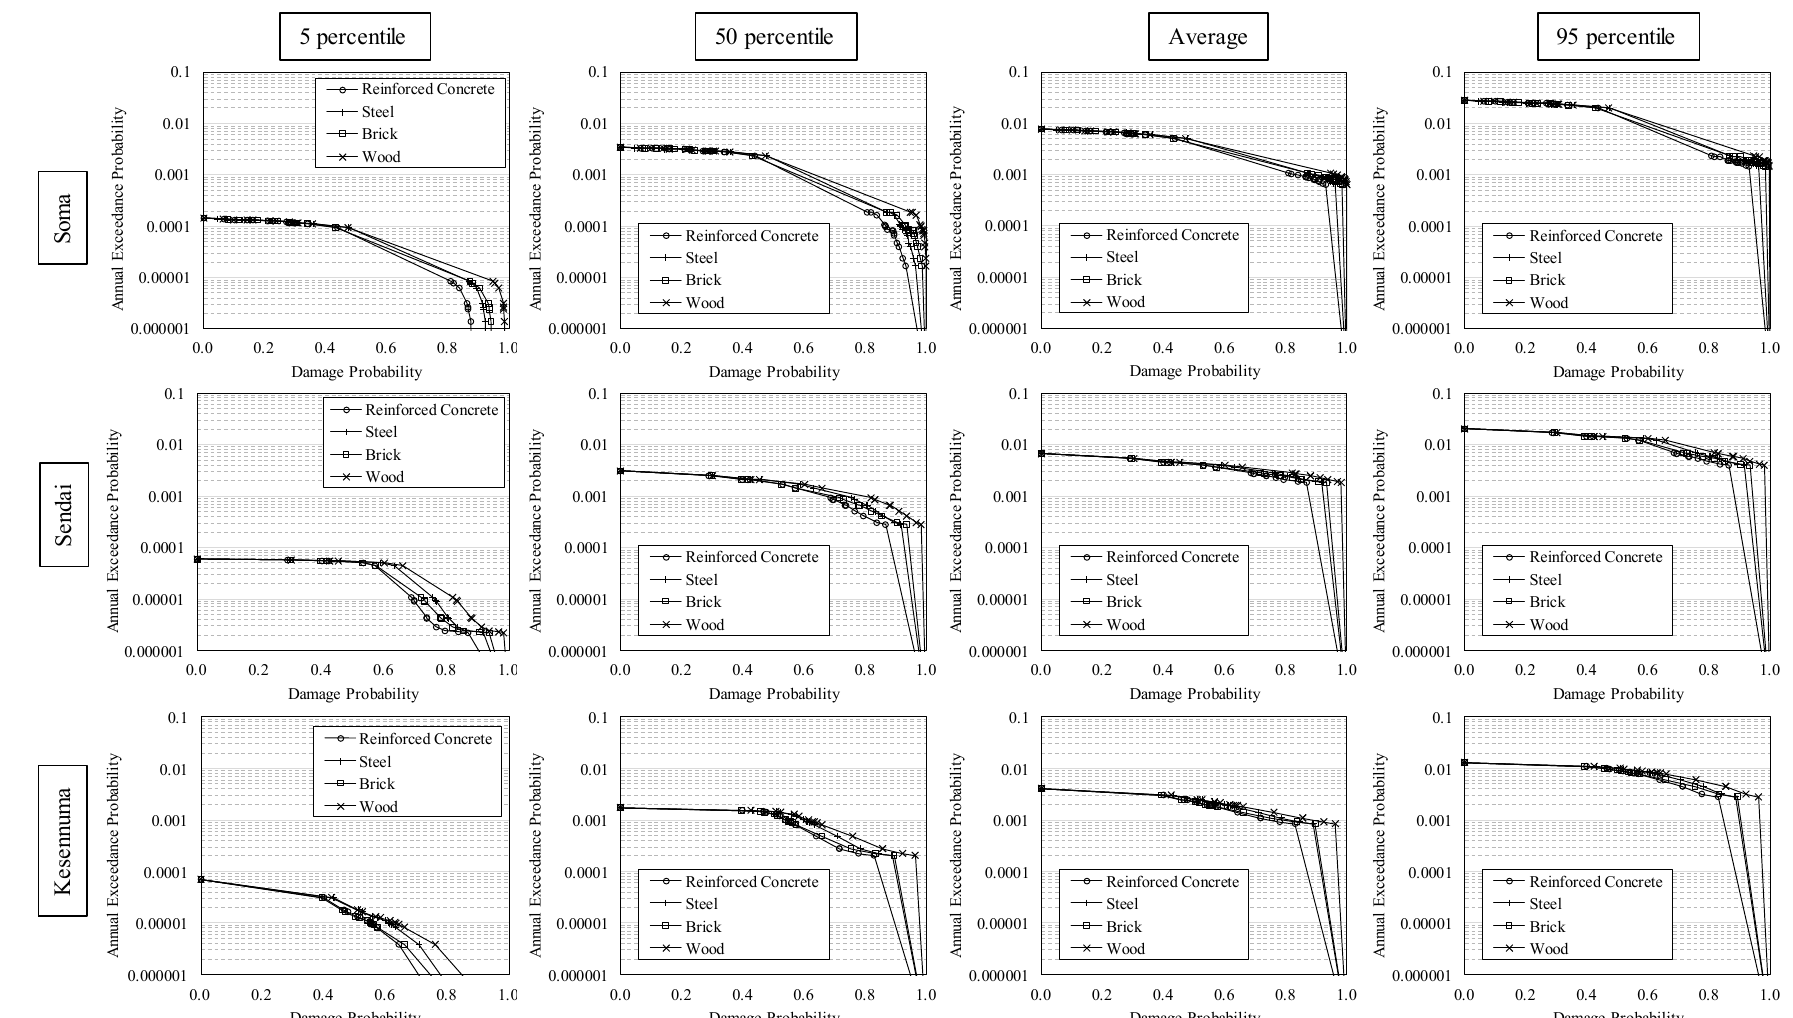
Figure 14. Tsunami risk curves for different types of building construction with different percentile of tsunami hazard for three target points.